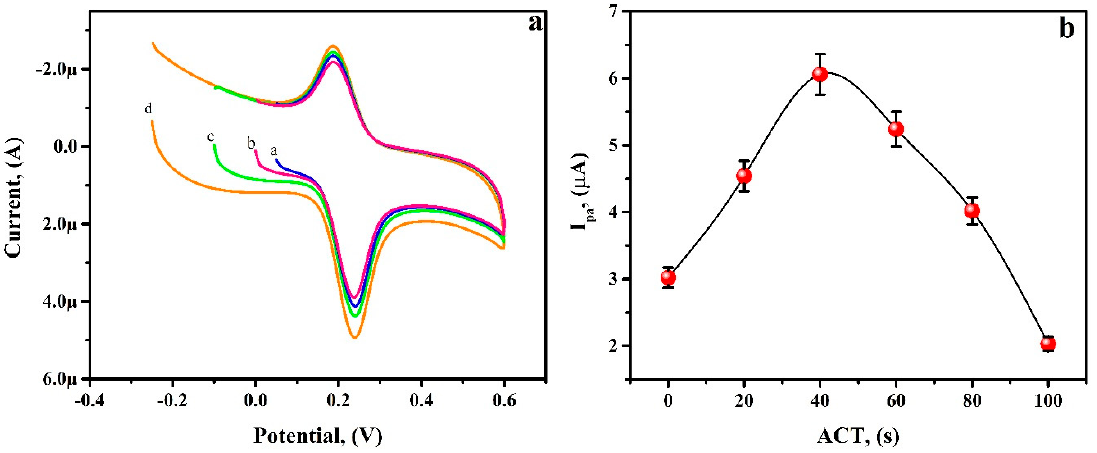
Figure 6. ( a ) CVs of accumulation potential versus I pa . ( b ) ACT versus I pa in optimum pH at a scan rate of 0.1 V/s. Scheme 2. Possible electrochemical redox reaction of RU at the surface of PGAMGPE.